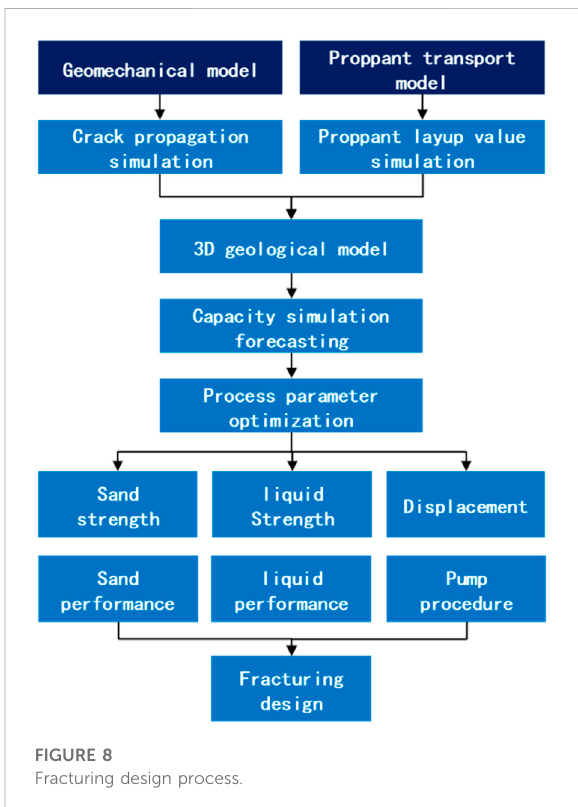
FIGURE 8 Fracturing design